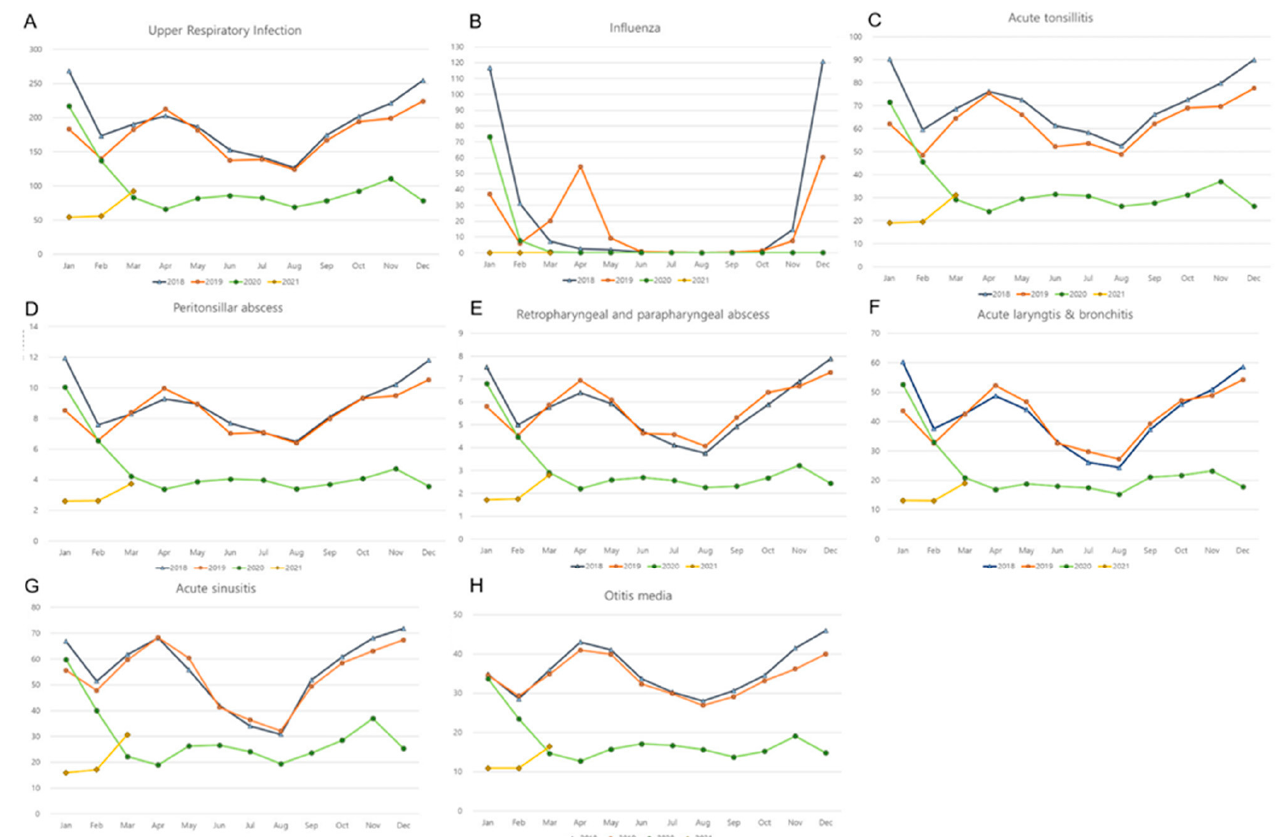
Figure 1. Monthly incidences of ( A ) upper respiratory infection, ( B ) influenza, ( C ) acute tonsillitis, ( D ) peritonsillar abscess, ( E ) retropharyngeal and parapharyngeal abscess, ( F ) acute laryngitis and bronchitis, ( G ) acute sinusitis, and ( H ) otitis media. (y-axis: x 10,000 person)